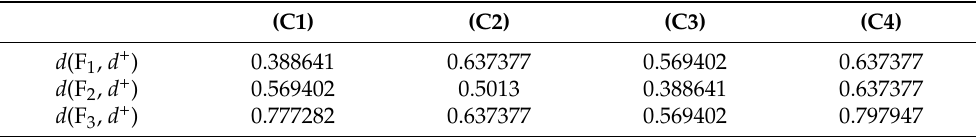
Table 10. Distance between alternatives from